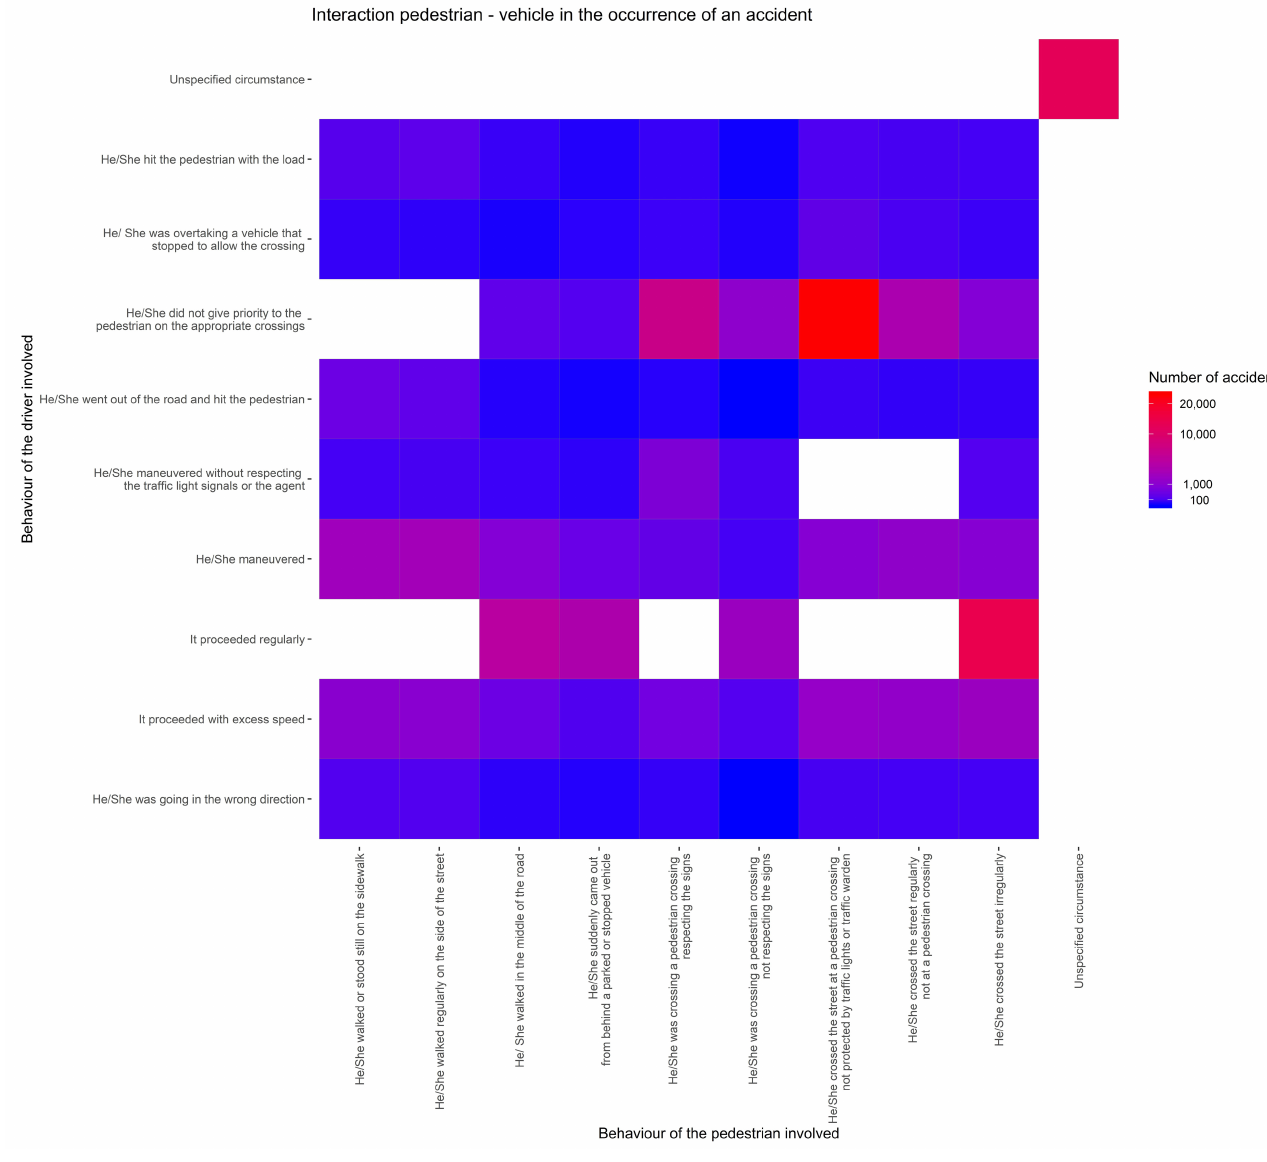
Figure 1. Number of accidents for each pedestrian–driver